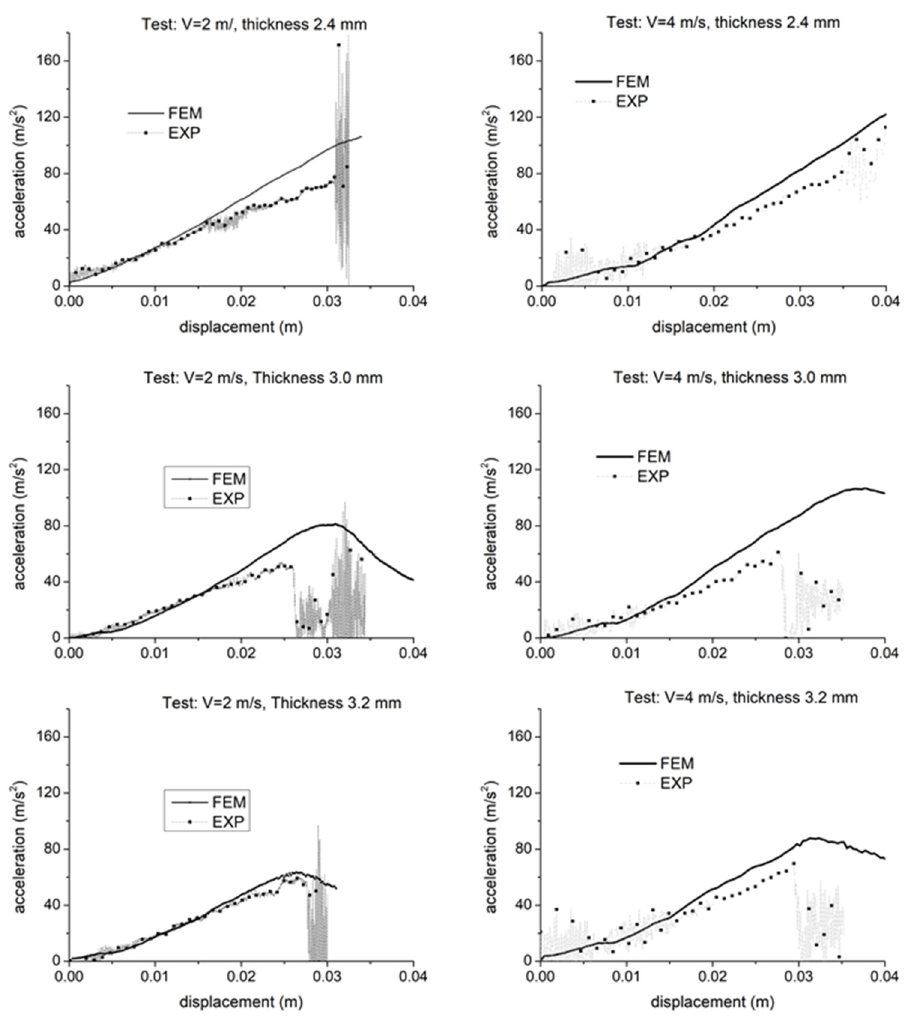
Figure 7. Force—displacement curves measured using the 65 mm-diameter hemispherical impactors: impact speed 2 m/s ( left ) and 4 m/s ( right ), nominal part thickness 2.4 mm ( top ), 3.0 mm ( central ), 3.2 mm ( bottom ).